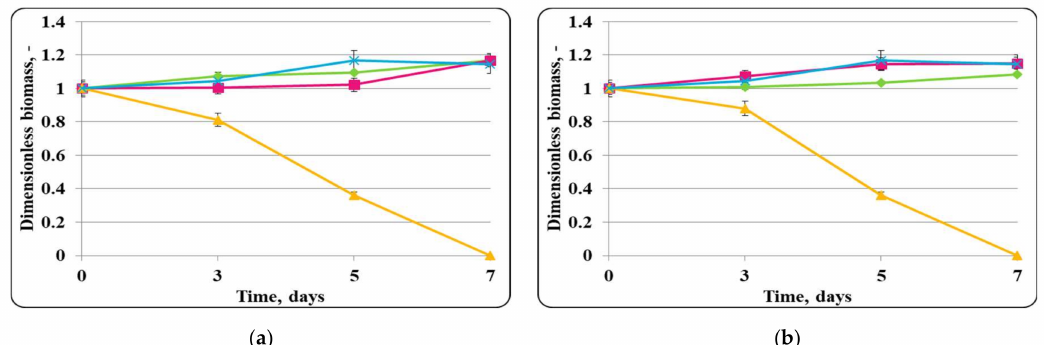
Figure 4. ( a ) free lactobacilli cells; ( b ) encapsulated lactobacilli cells. Changes in the dimensionless biomass of Lb. helveticus 2/20 and E. coli ATCC 25922 in chocolate mousse at 20 ± 2 ◦ C. Legend: Green (cid:117) : Lb. helveticus 2/20 population following its inoculation; Pink (cid:4) : Lb. helveticus 2/20